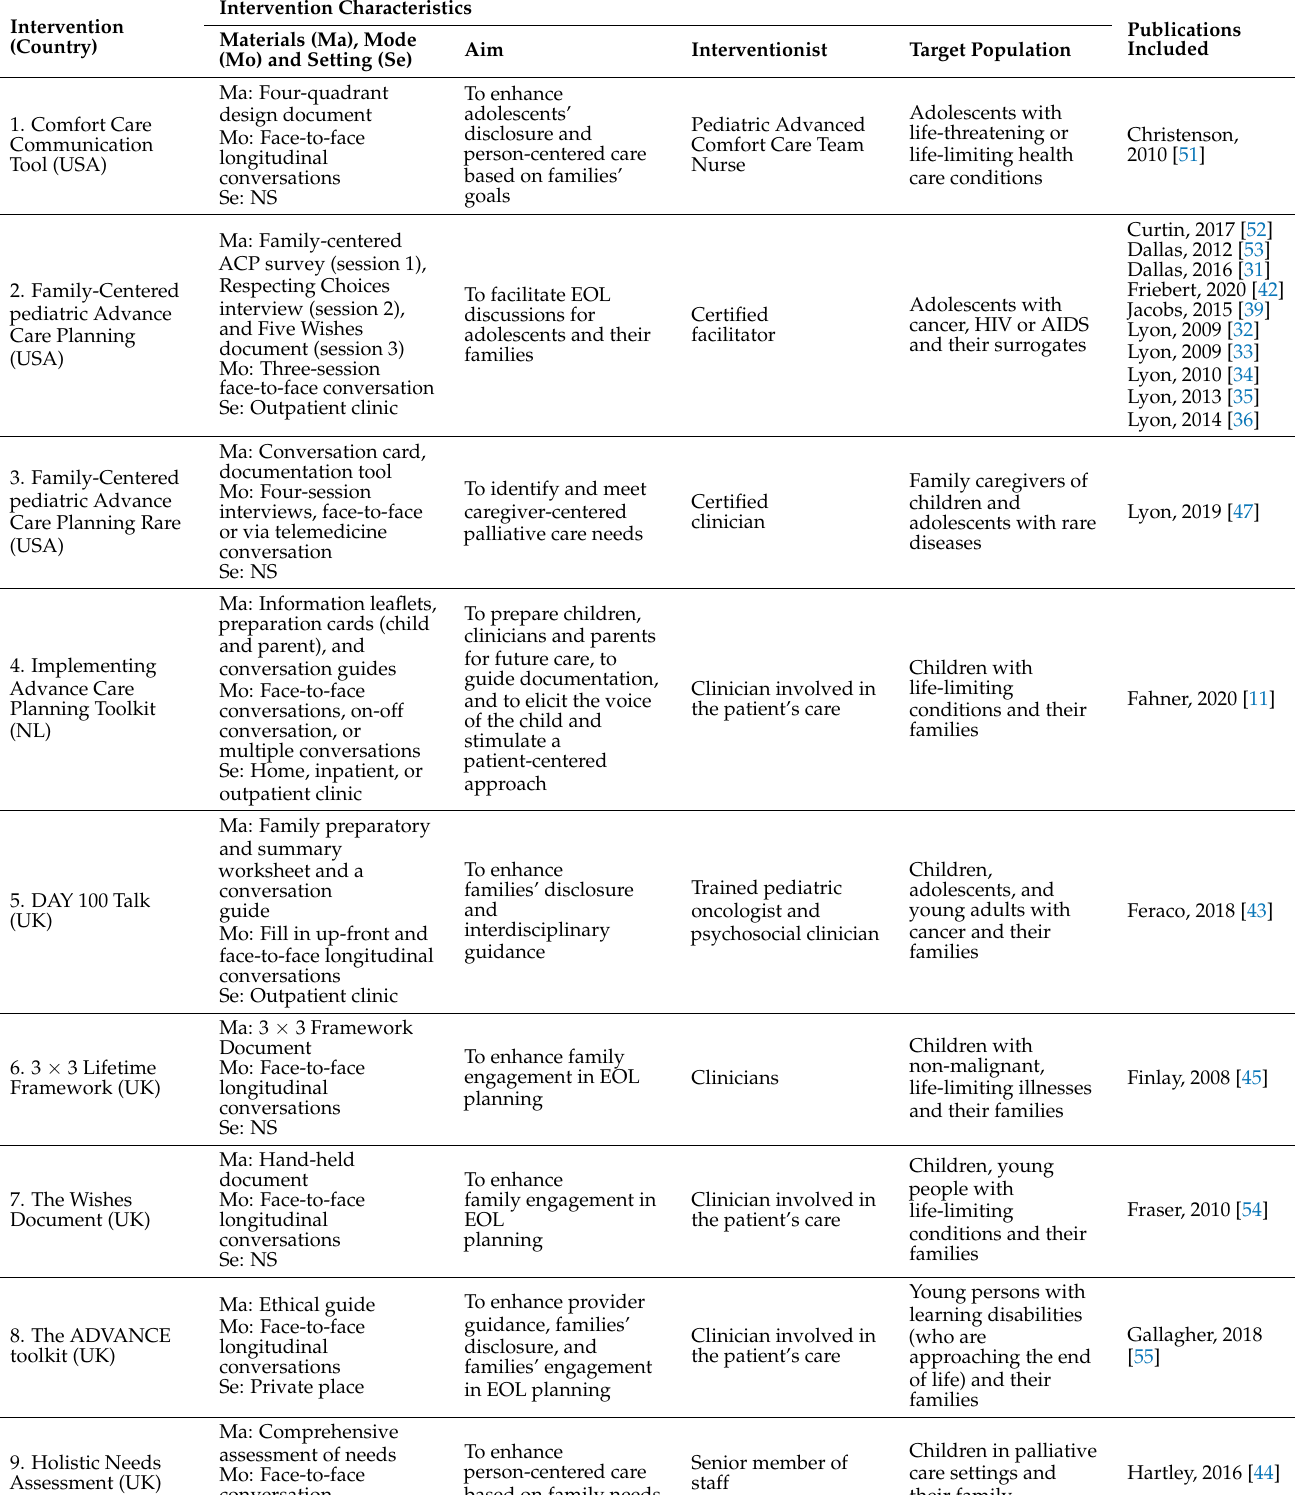
Table 7. Intervention